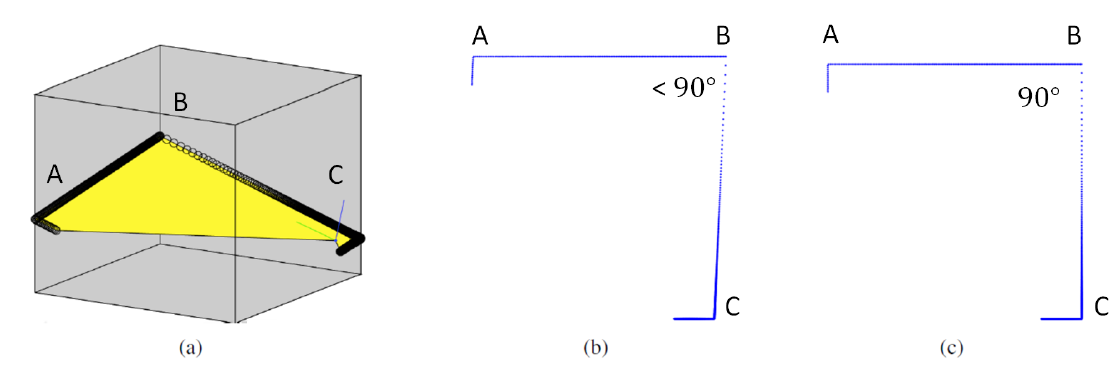
Figure 4. An example of scan projection. ( a ) An off-axis scanner in a cubic environment. ( b ) The raw readings of the laser scanner. Note that the angle ABC is less than 90 ◦ due to scan warping. ( c ) After projection the angle ABC has been corrected to 90 ◦